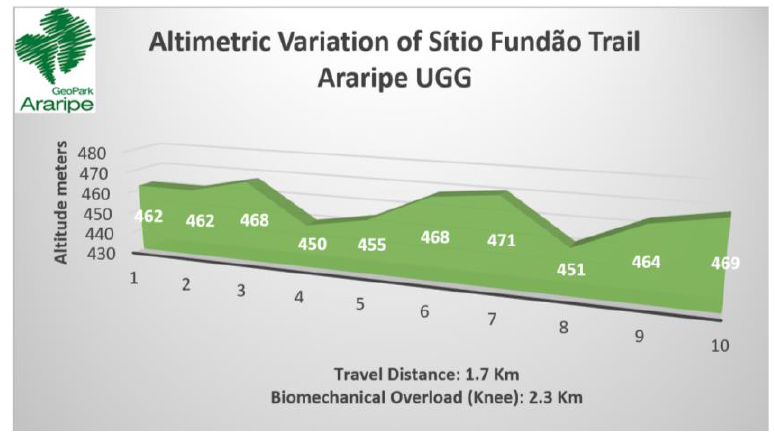
Figure 11. Altimetric Variation of Sítio Fundão trail; Araripe UGG. Source: Research Collection. Table 8. Effort Index Classification by route and total of the Pontal de Sta. Cruz Trail; Araripe UGG.